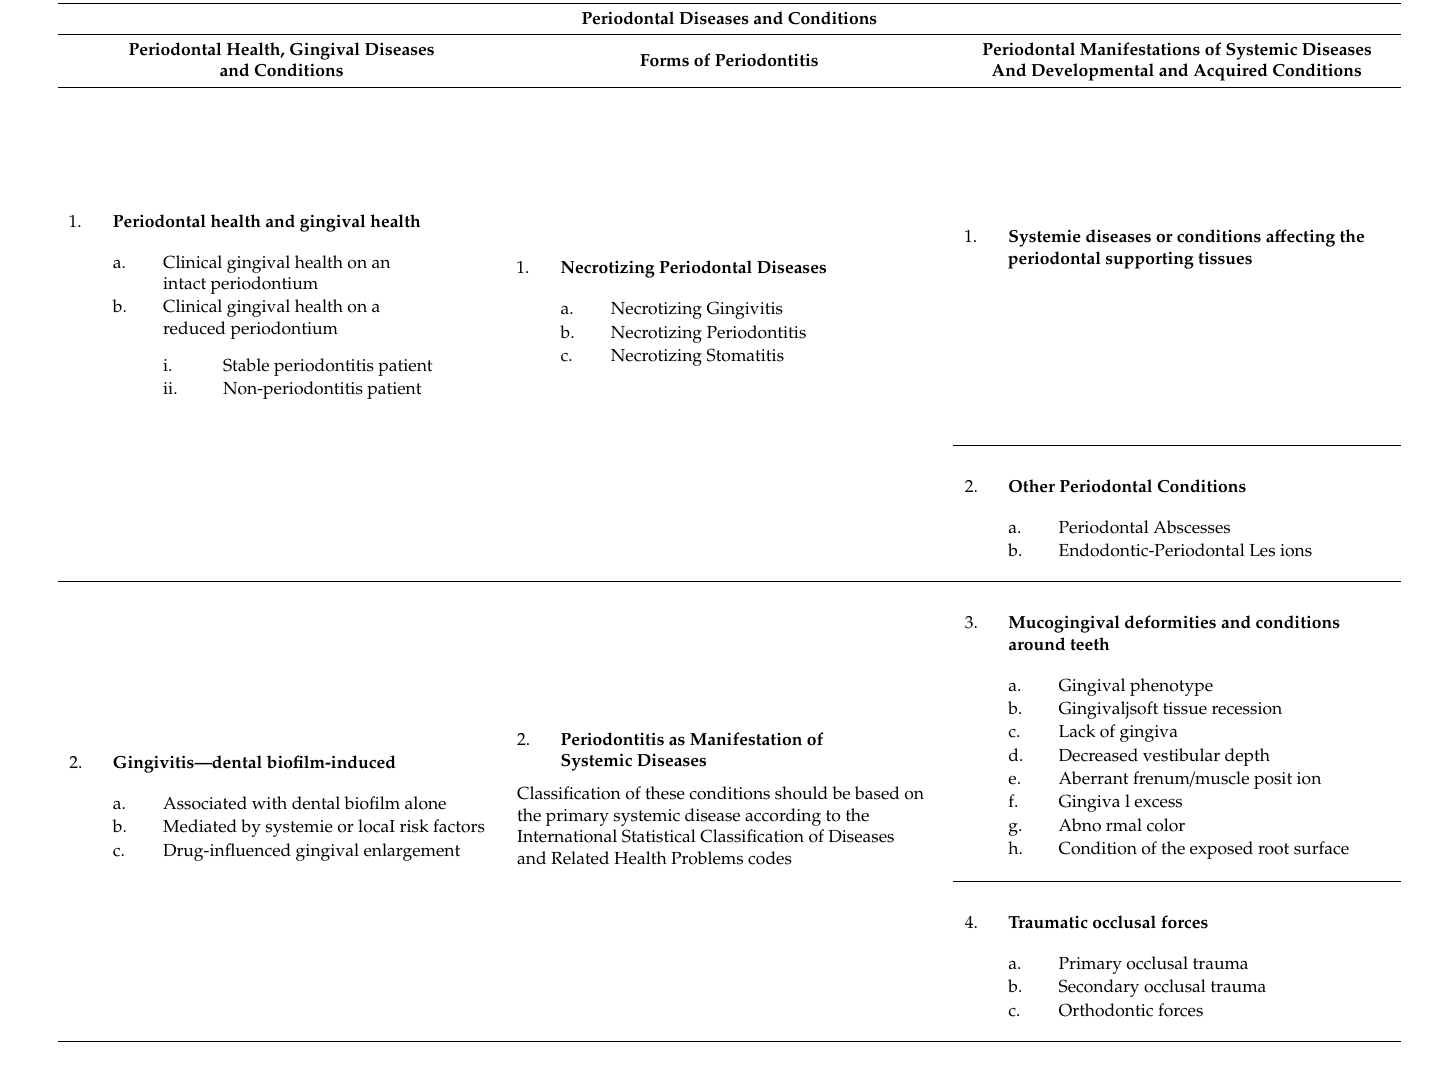
Table 3. A new classification scheme for periodontal and peri-implant diseases and